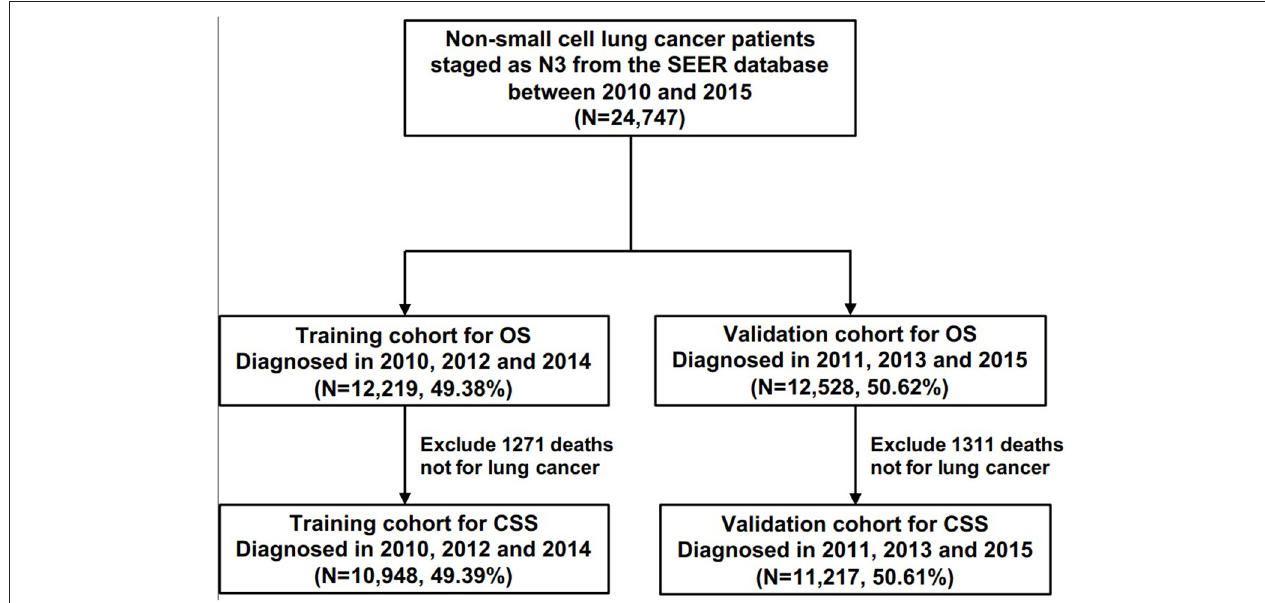
FIGURE 1 | The flow chart of patients for the training and the validation cohorts for the development of predictive